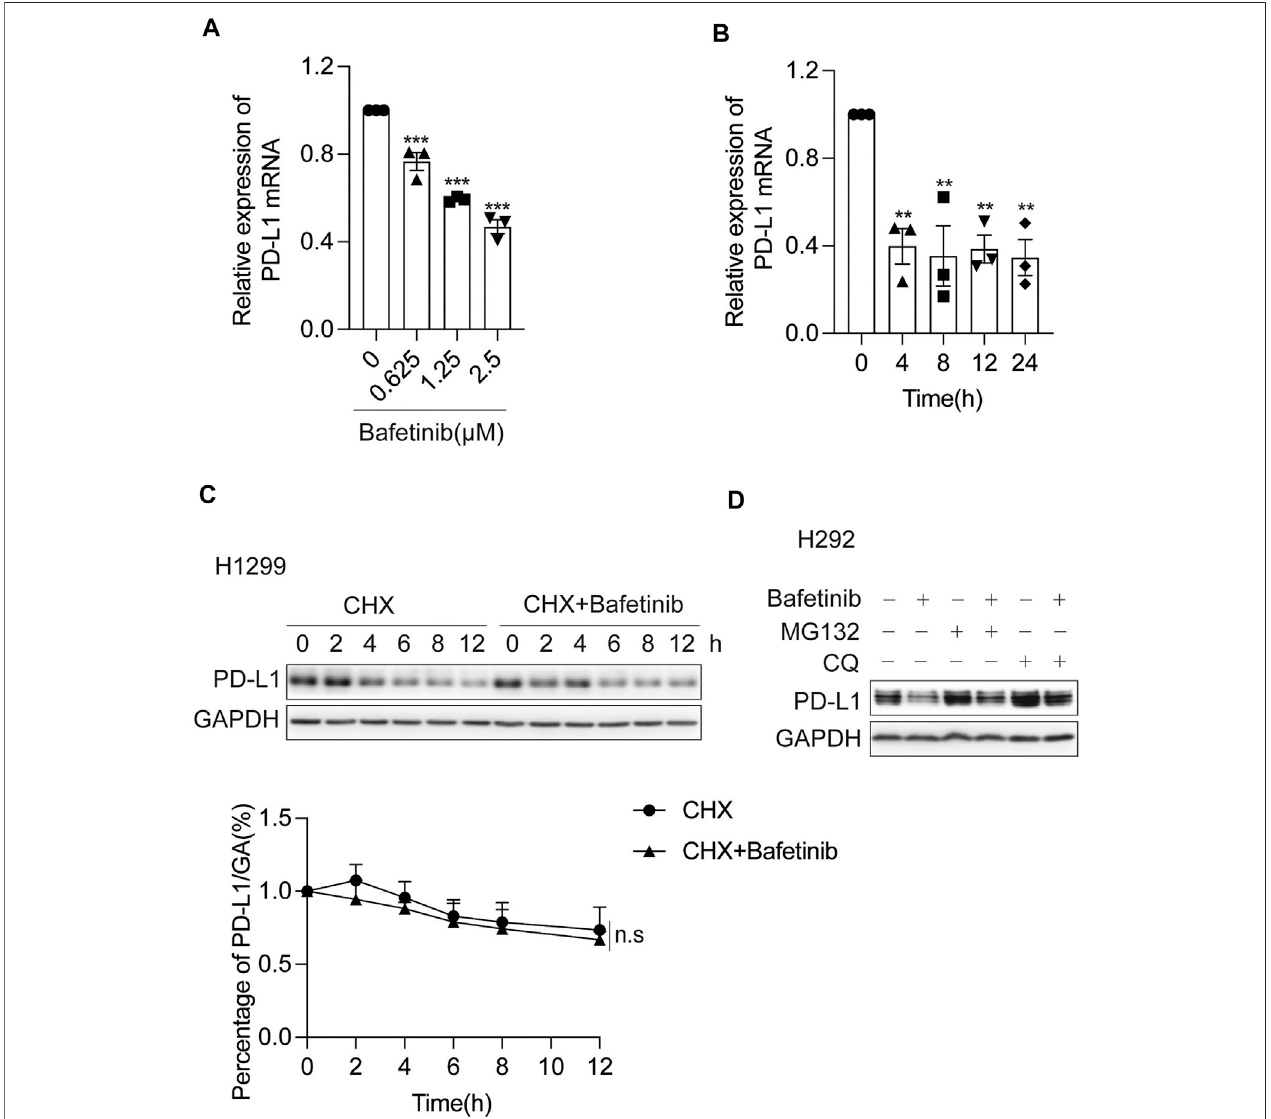
FIGURE2| BafetinibinhibitsthetranscriptionofPD-L1. (A) H292cellsweretreatedwithBafetinib(0.625,1.25,and2.5 μ M)for24 h,thentherelativeexpressionof PD-L1mRNAwasquanti fi edbyqRT-PCR n =3. (B) H292cellsweretreatedwithBafetinib(2.5 μ M)for0,4,8,12,and24 h,thentherelativeexpressionofPD-L1mRNA wasquanti fi edbyqRT-PCR n =3. (C) WesternblotofPD-L1proteininH1299cellswithorwithoutBafetinibinthepresenceofCHXat10 μ g/mlfor0,2,4,6,8,and12 h. TherelativeproteinlevelofPD-L1wasanalyzedquantitativelybelow n =3. (D) WesternblotofPD-L1proteininH292cellswithorwithoutthetreatmentofBafetinib (2.5 μ M)meanwhilethecellsweretreatedwithMG132(10 μ M)orCQ(20 μ g/ml)for10 h.Thedatawereanalyzedbyone-wayANOVAwithDunnett ’ sposthoctestorthe Students ’ t-test. ***, p < 0.001; **, p < 0.01; n. s: not signi fi cant.